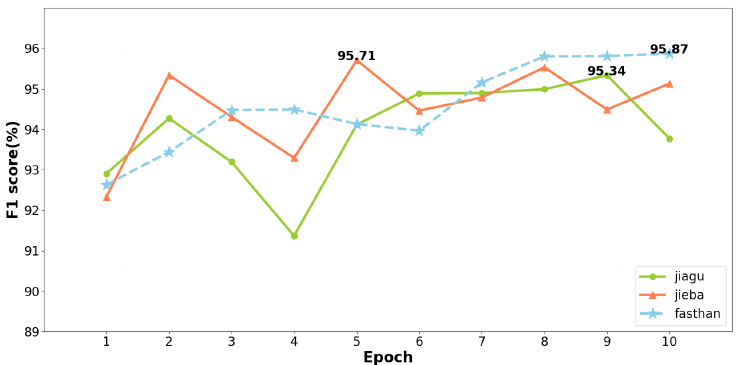
Figure 3. F1 scores of Different Tokenizers on Resume (%).